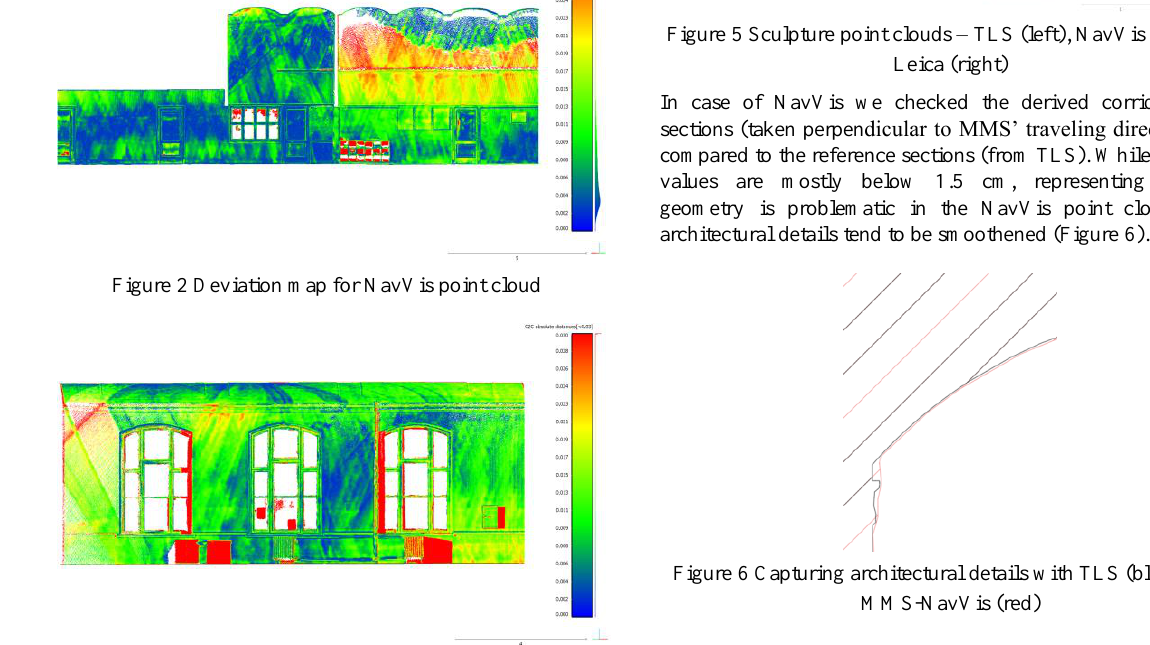
Figure 3 Deviation map for NavVis point cloud - details